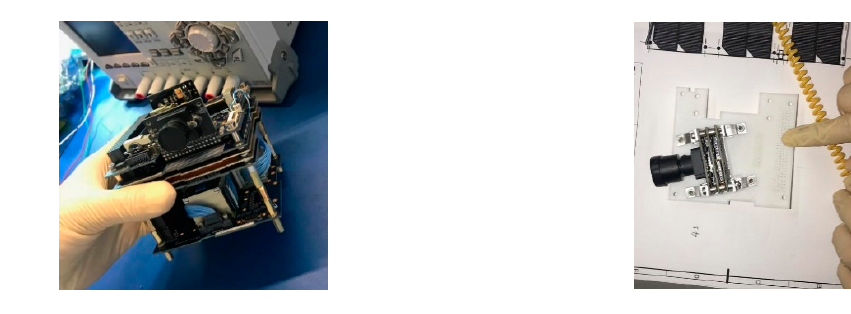
Figure 8. Integrated CubeADCS ( left ) and star tracker ( right ).